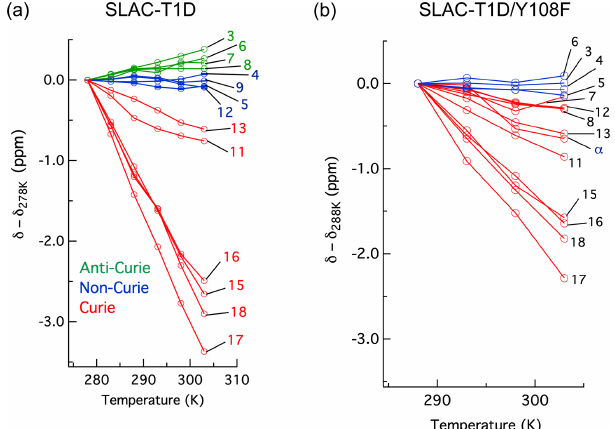
Figure 5. Change in 1 H chemical shifts for (a) SLAC-T1D with temperature relative to 278K and (b) SLAC-T1D/Y108F with tem- perature relative to 288K. Anti-Curie, non-Curie and Curie be- haviours are shown in green, blue and red,